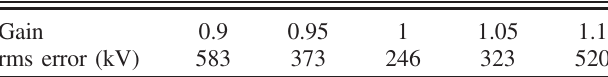
TABLE III. rms error with feedforward gain (feedback off). Uncompensated beam loading.